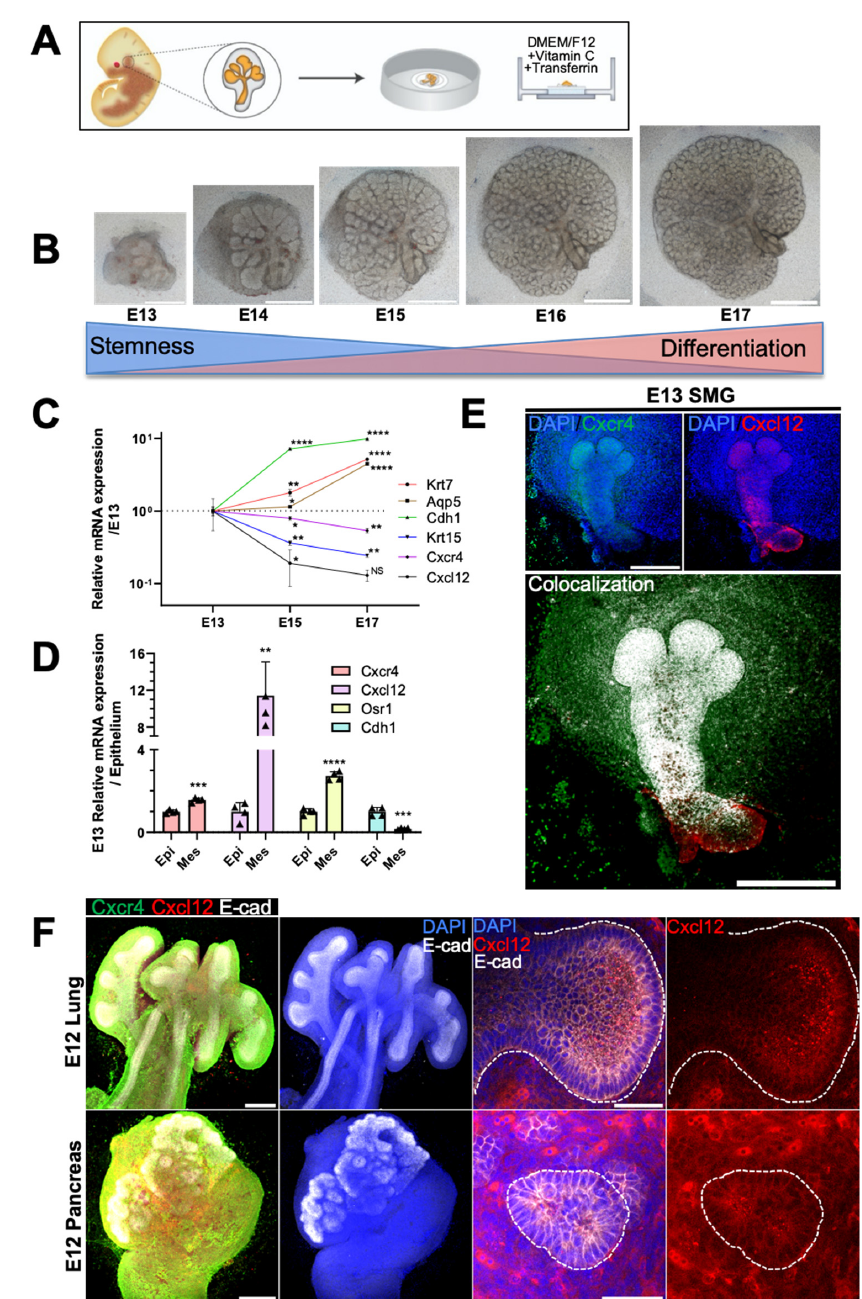
Figure 1. Spatiotemporal expression of CXC-chemokine receptor 4 (CXCR4) and its ligand, CXCL12, and developmental genes in embryonic organs. ( A ) Schematic diagram of embryonic submandibular gland (eSMG) isolation and ex vivo culture. ( B ) Ex vivo branching morphogenesis of eSMGs from embryonic day (E) 13 to 17, showing epithelial growth and retraction of mesenchyme. Scale bars: 500 µ m. ( C ) Temporal mRNA expression patterns of keratin 7 ( Krt7 ), aquaporin 5 ( Aqp5 ), e-cadherin ( Cdh1 ), Krt15 , Cxcr4 , and Cxcl12 were measured from E13 to E17 by qPCR ( n = 3). ( D ) Epithelial (Epi) and mesenchymal (Mes) expression of Cxcr4 , Cxcl12 , odd-skipped related transcription factor 1 ( Osr1 ), and Cdh1 were quantified by qPCR at E13. The comparative C t values are expressed as fold increase relative to the epithelium ( n = 3). ( E ) Representative images showing expression of CXCR4 and CXCL12 in eSMG (upper) and their colocalization (lower) ( n = 3, scale bar: 500 µ m). ( F ) Representative immunofluorescence images of CXCR4 and CXCL12 expression in E12 embryonic lung and pancreas ( n = 4); whole view (left two panels; scale bar: 500 µ m) and magnified lumen structures (right two panels; scale bar: 50 µ m). Data are presented as the mean ± SEM; * p < 0.05, ** p < 0.01, *** p < 0.001, **** p < 0.0001, NS: not significant; two-way ANOVA ( C ); t -test ( D